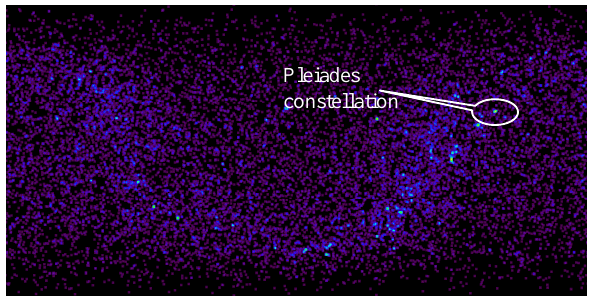
Figure 5 : compliant stars within a single PHR